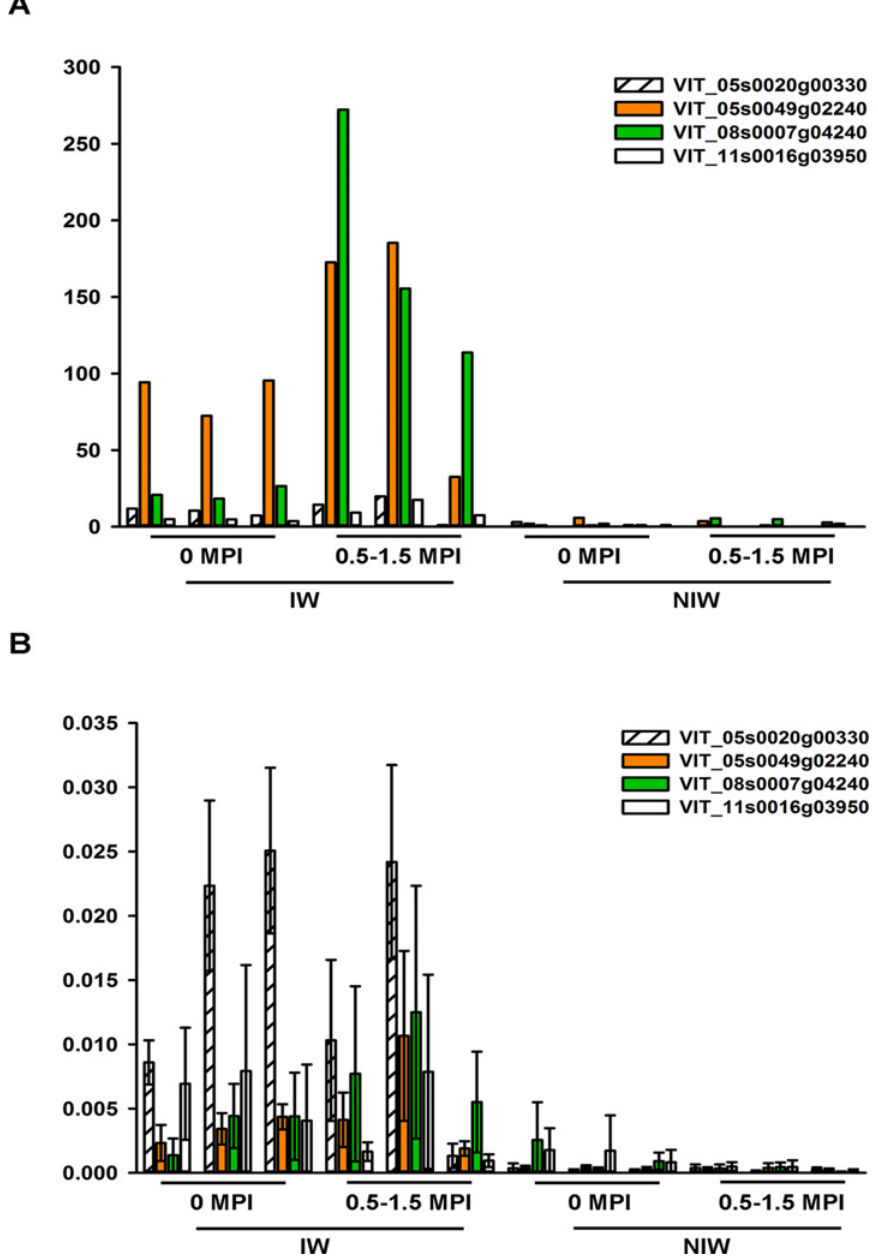
Fig 5. Differential expression analysis of four candidate genes: a galactinol synthase (VIT_05s0020g00330), an abscisic acid-induced wheat plasma membrane polypeptide 19 ortholog (VIT_05s0049g02240), an embryonic cell protein 63 (VIT_08s0007g04240), and a BURP domain- containing protein (VIT_11s0016g03950). (A) DESeq analysis of differential expression. Each column represents the normalized read counts from RNA-Seq of one replication. (B) qPCR validation of DESeq counts. Transcript levels of marker genes were corrected to VvUbiquitin1 (TC32075). Each column is the mean of six replicate PCR reactions. Error bars represent standard